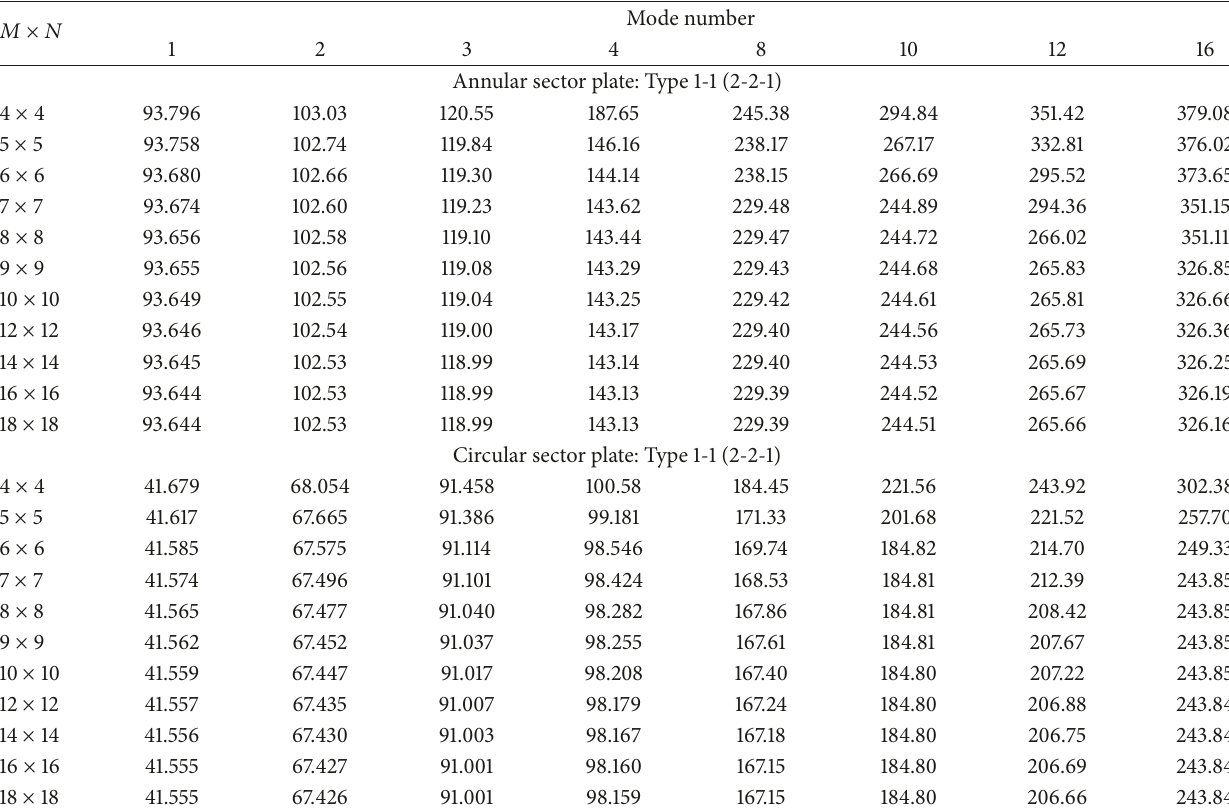
Table 2: Convergence of frequency parameters Ω for clamped annular sector plate and circular sector plate ( 𝑅 0 /𝑅 1 = 0.5 , 𝜙 = 120 ∘ , ℎ/𝑅 1 = 0.2, and 𝑝 1 = 𝑝 3 = 5